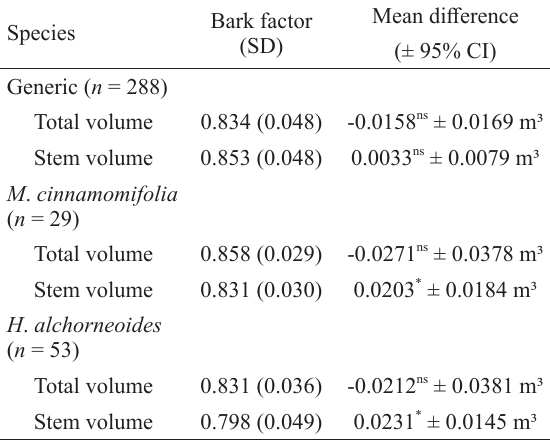
Bark factors, mean paired differences between the observed total and stem inside bark volume and the predicted inside bark volume using the generic and species-specific models and bark